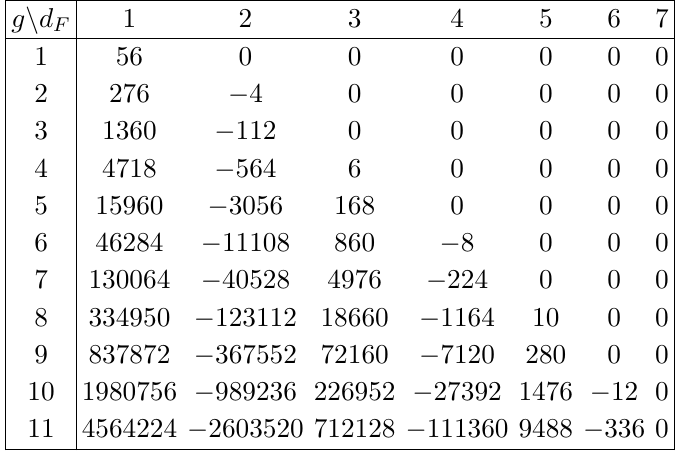
for ( F 4 ! F 1 )[SU(2) (cid:2) Z 2 ] (cid:0) 144 d F ;d E =0